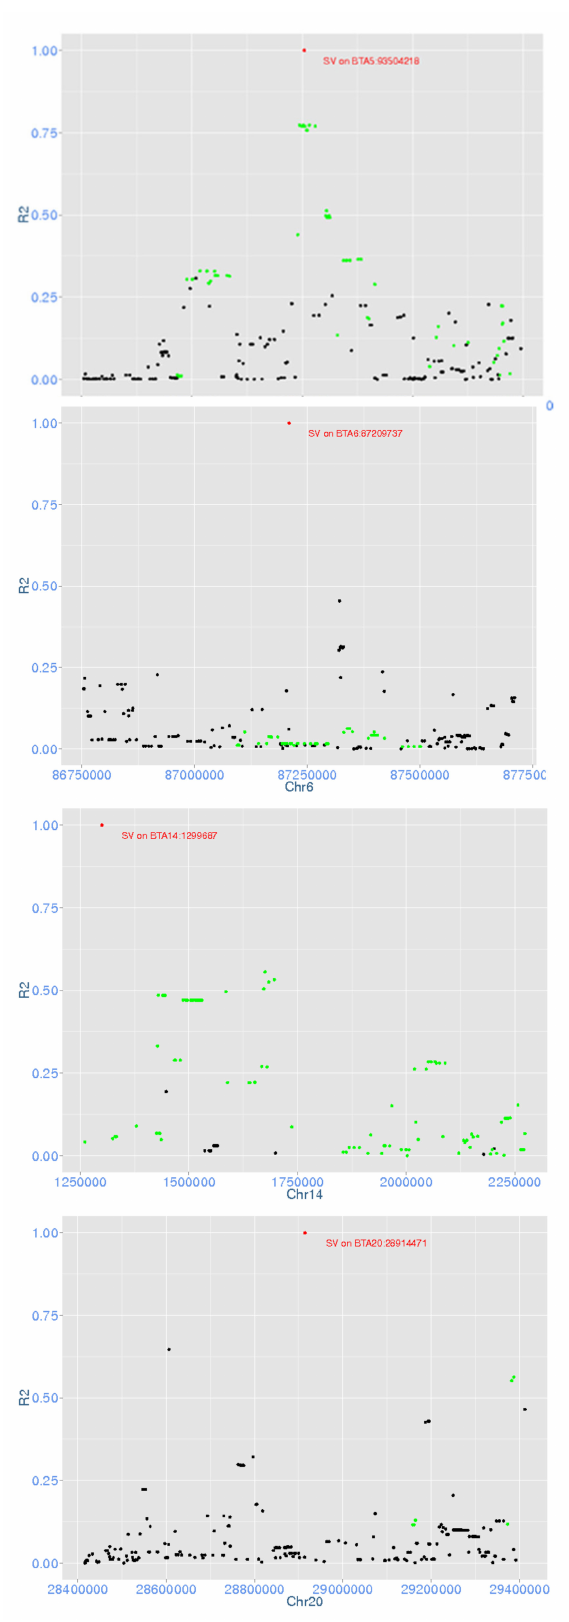
Figure 4. Linkage disequilibrium (LD) of four significant deletions with their surrounding SNPs. In each figure, the red spot is the deletion, black spots are surrounding SNPs and green spots are SNPs that are significant for multi-trait meta-analysis of production traits with p -value < 10 − 7